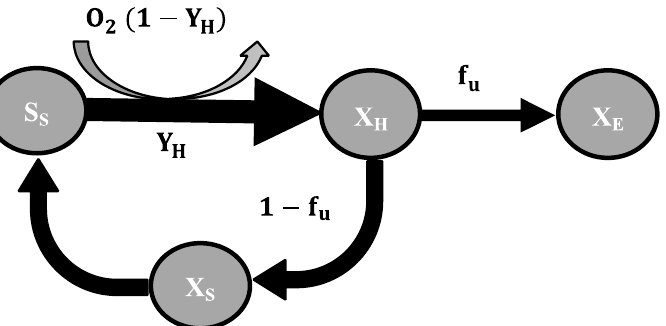
Figure 2. Principle of the death-regeneration